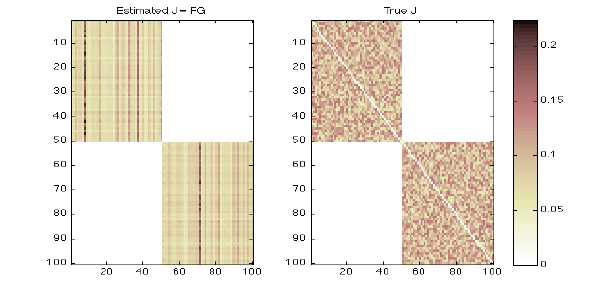
Figure 1: Heatmap of J = FG for 2 -clique network of 100